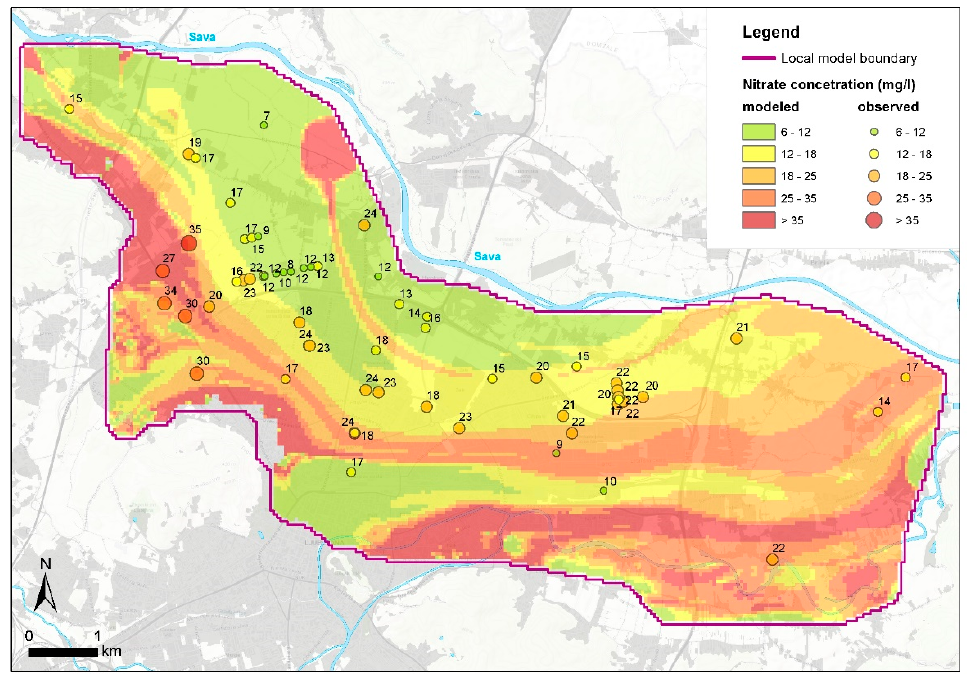
Table 4. Summary statistics for modeled and observed nitrate concentrations at observation locations (Table S1).